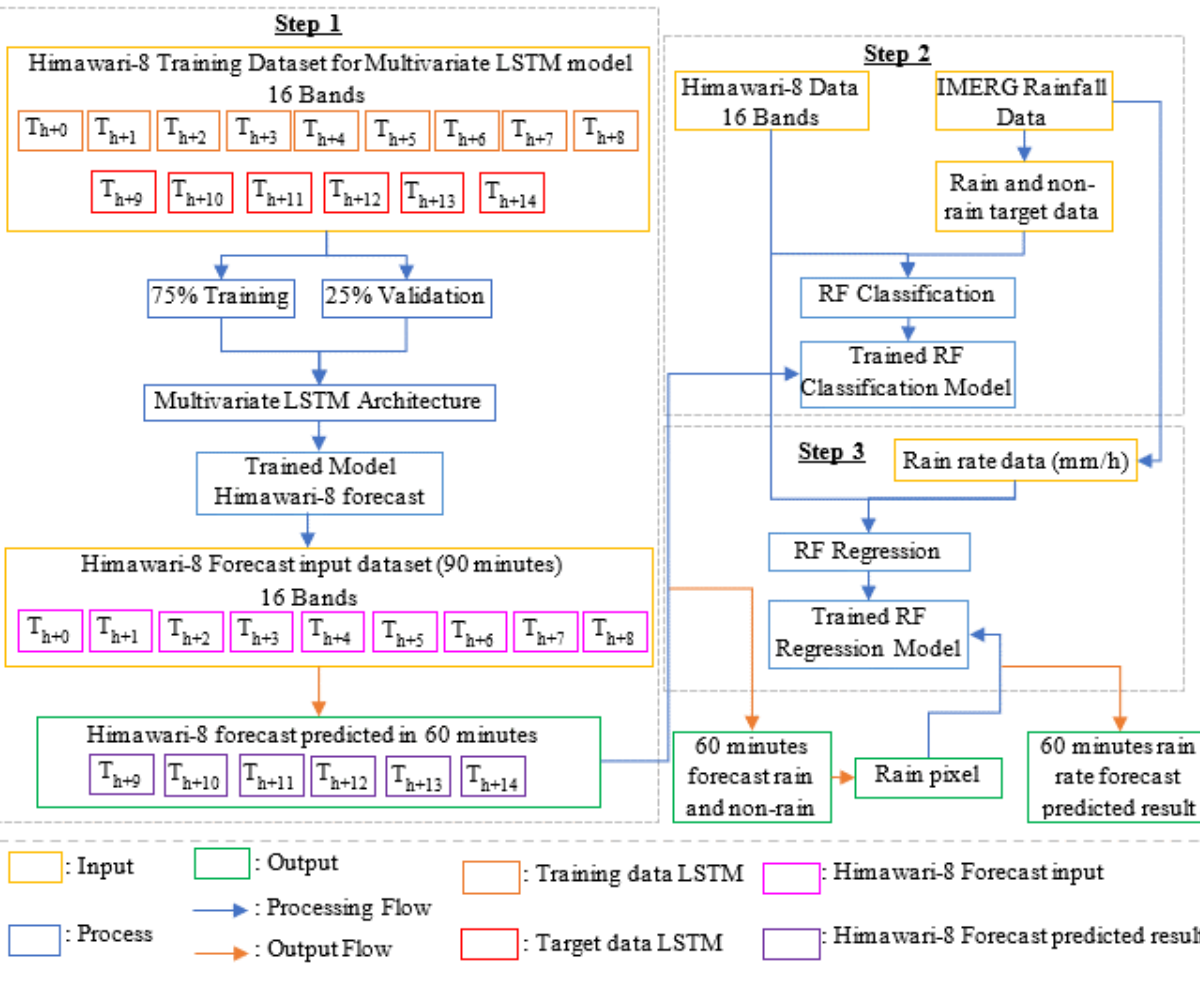
Figure 2. The machine learning approaches. T h+n represents the time step of data, RF and LSTM are stands for random forest and long short-term memory,